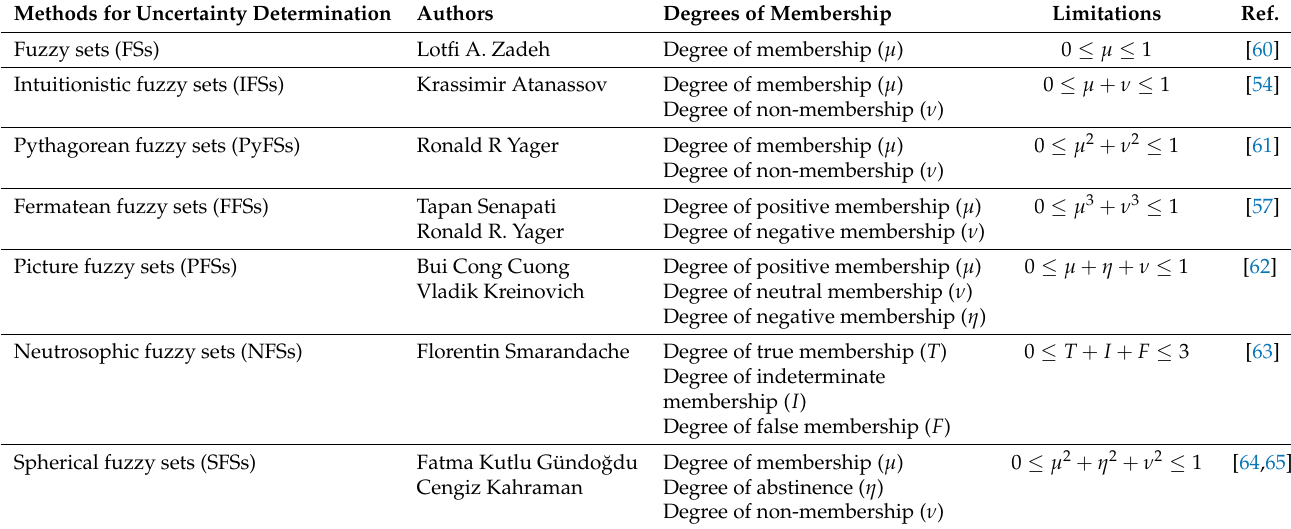
Table 1. Overview of fuzzy set